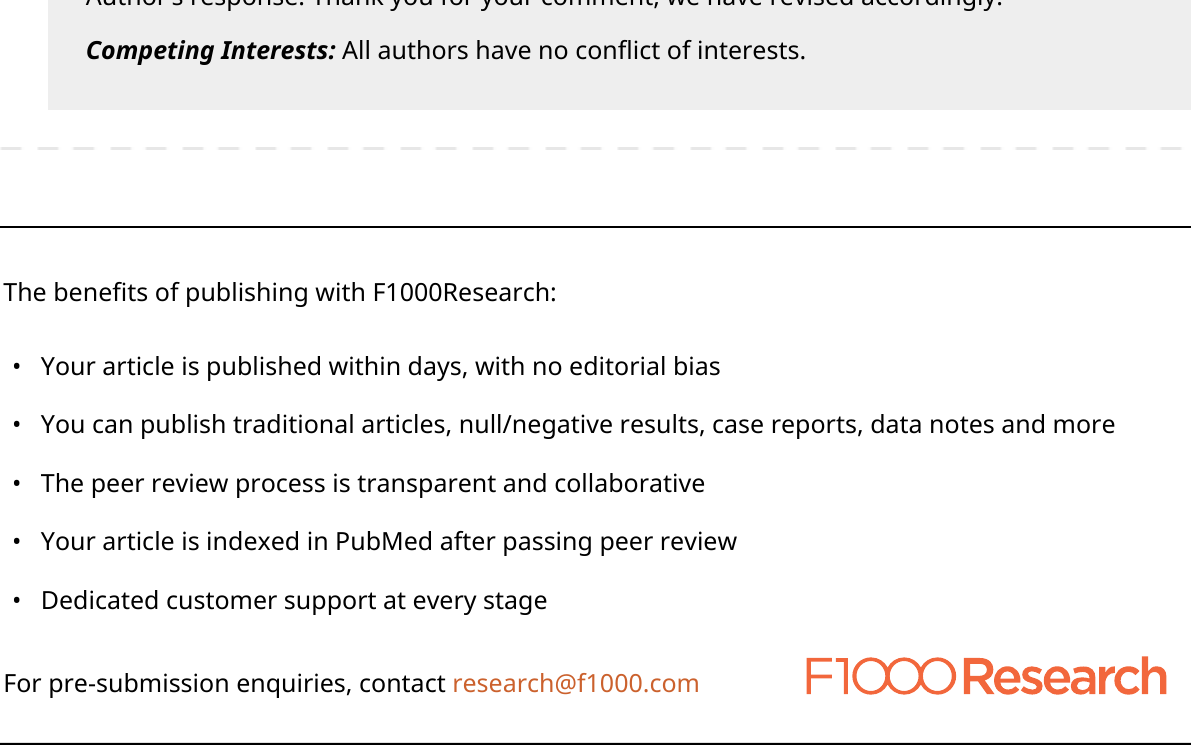
Figure 2,3 Question: Why the authors choose the order of categories in the X-axis is not